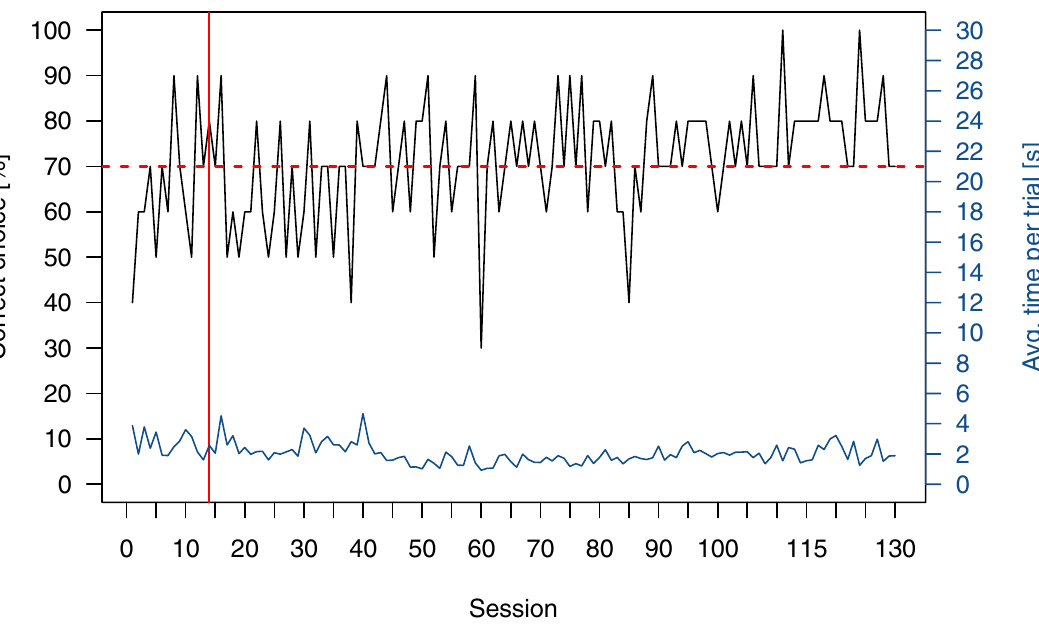
Figure 4. Exemplary graph of the performance of a cichlid during the entire training and testing (overtraining) phase. The black line shows the percentage of correct choices per ten-trial session. The horizontal red dotted line indicates the time the LC was reached, while the vertical red line indicates when the LC was achieved. In the sessions following the red vertical line, transfer tests were added to the regular ten trial session. The blue line gives the average trial time for each session.